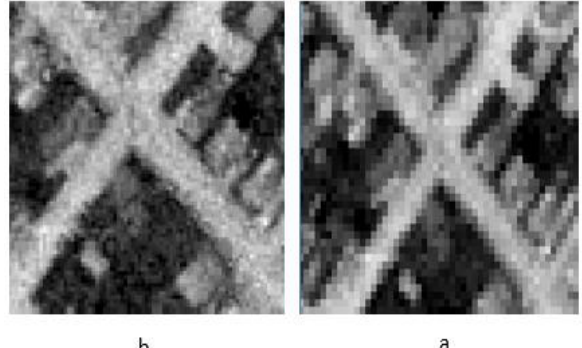
Although, decreasing the spatial resolution of the data will increase the spectral content and SNR. Obviously, in figure 7 quantity of the TIR data is improved by applying the decreasing spatial resolution procedure. Nonetheless the sharpness of the data is losing (figure 7). As illustrated in figure 7, the edges in 1-meter TIR data are very sharper than the edges in 2-meter data. But the noise is very obviously distributed in original TIR data while in 2-meter one is decreased.